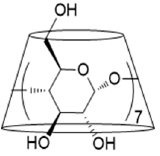
Figure 1. General structure of β -cyclodextrin ( β -CD).